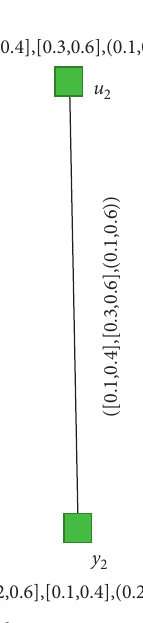
Figure 11: Cubic intuitionistic fuzzy